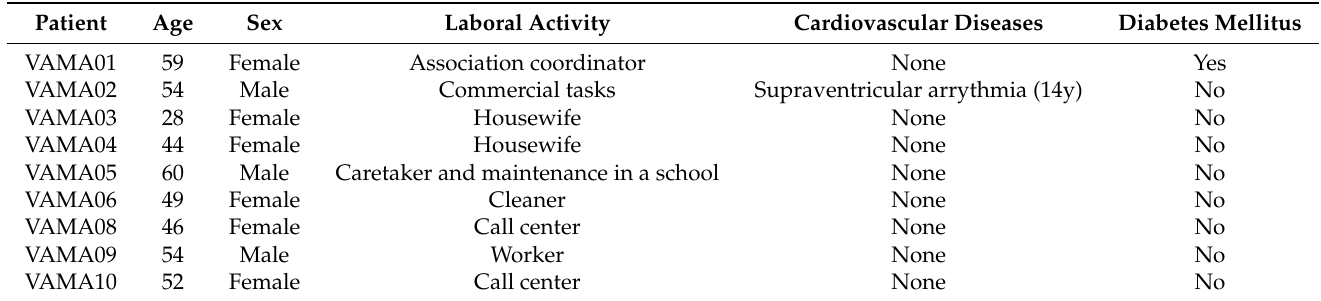
Table 2. Demographic, clinical characteristics and medical history of patients before COVID-19 diagnosis.